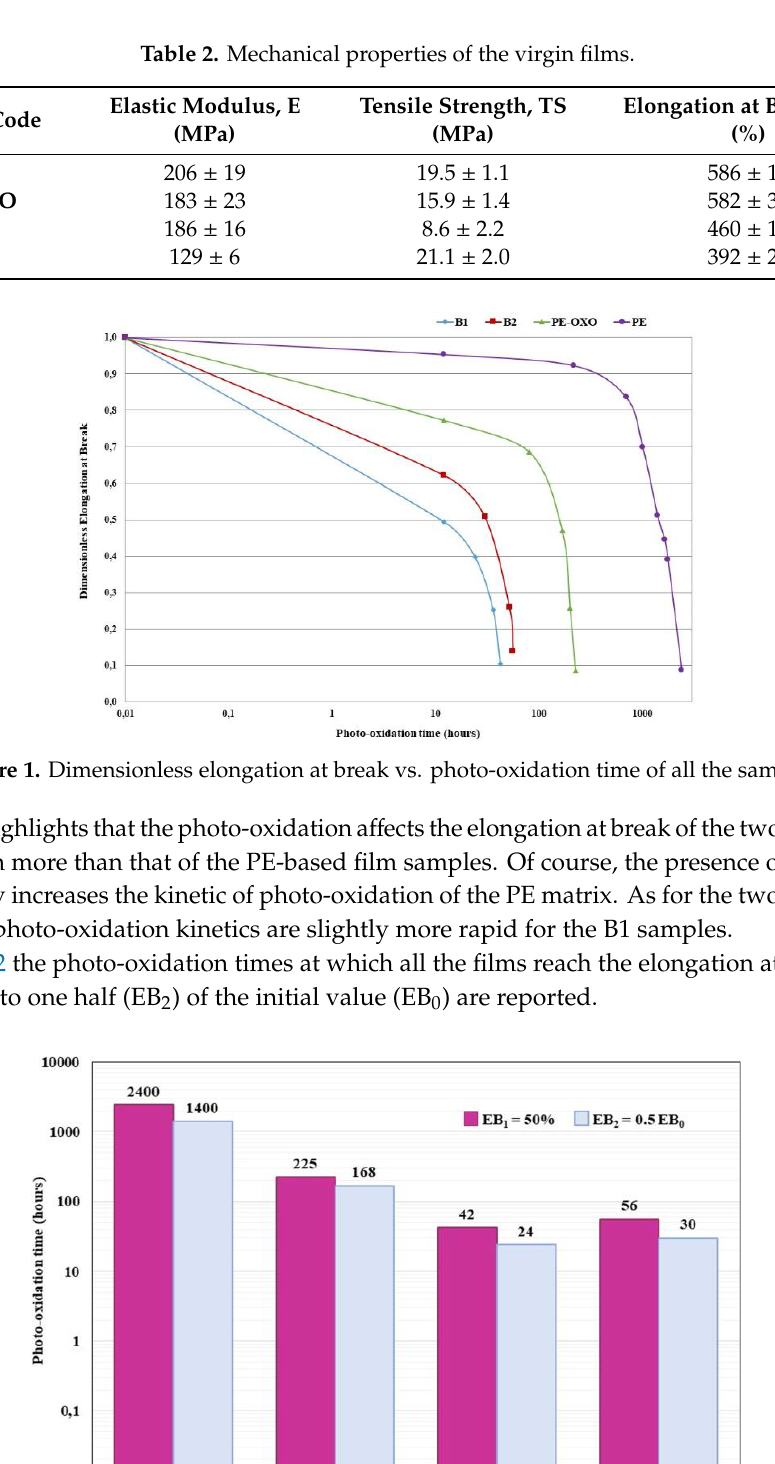
Figure 2. Photo-oxidation times (hours) of different samples when the elongation at break reaches the value of 50% (EB 1 ) and one half of the initial value (EB 2 ).